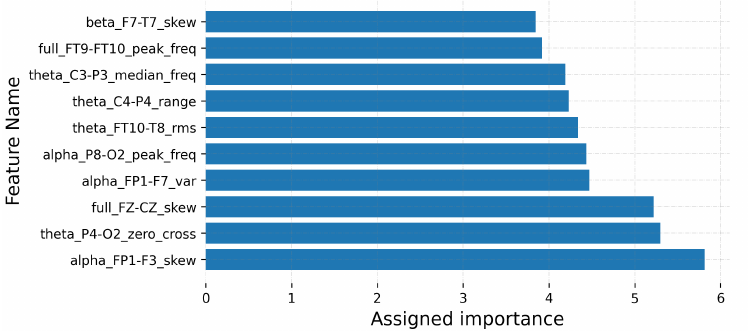
Figure 11. Features having the largest assigned importance. The results correspond to the combina- tion KNN-SVM and the CHB-MIT dataset. Importance values are not normalized.